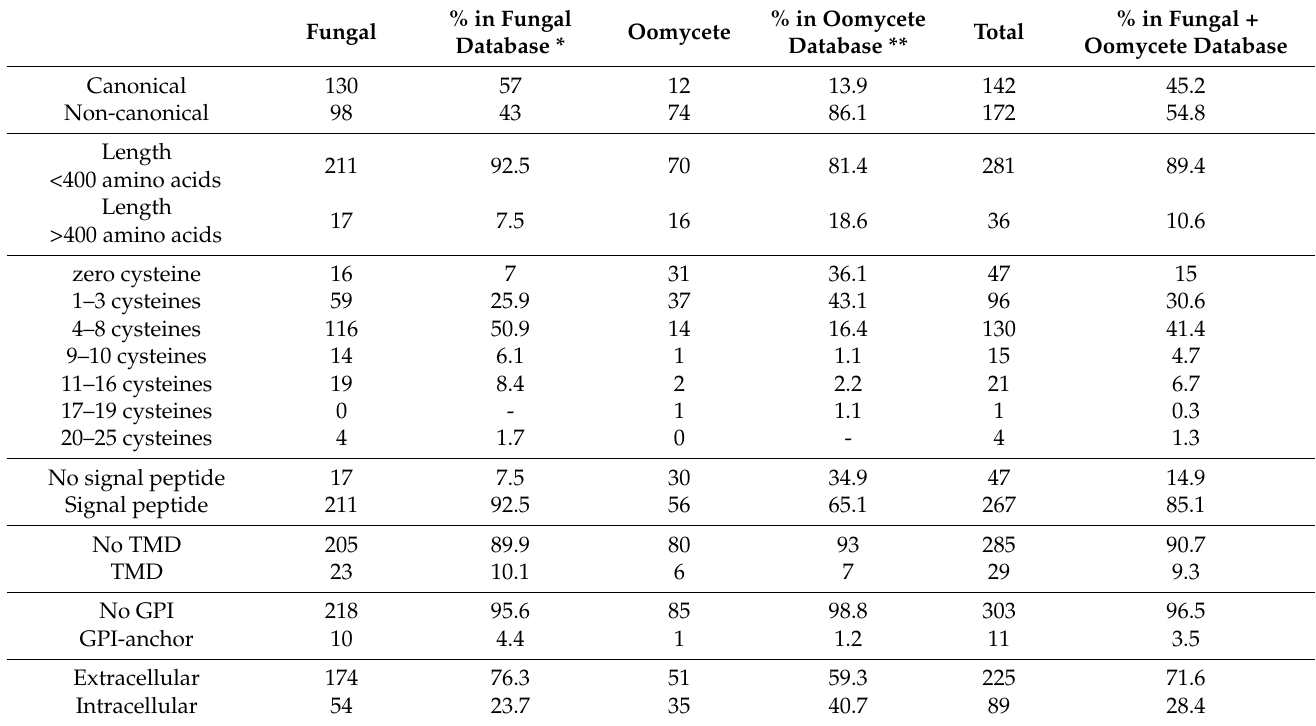
Table 3. Characterization and comparison of fungal and oomycete